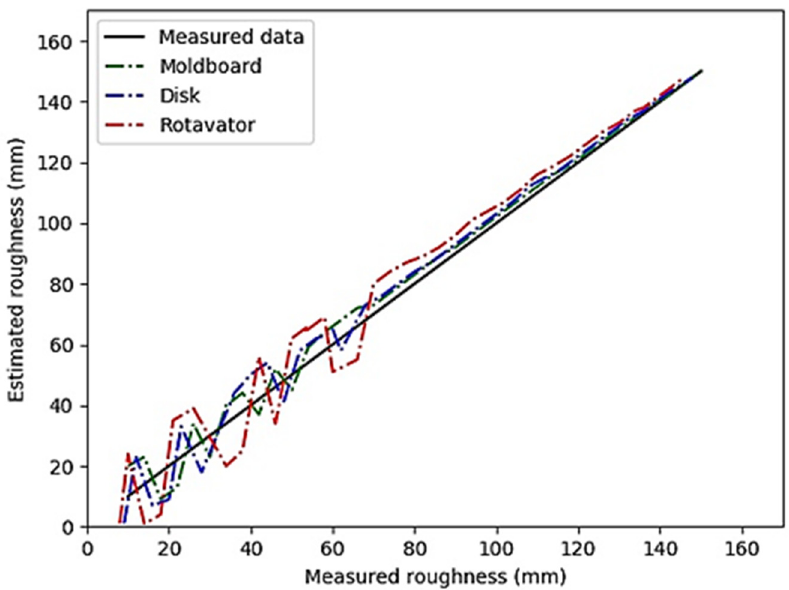
Figure 7. Comparison of the measured and estimated soil surface roughness for three tillage implements.